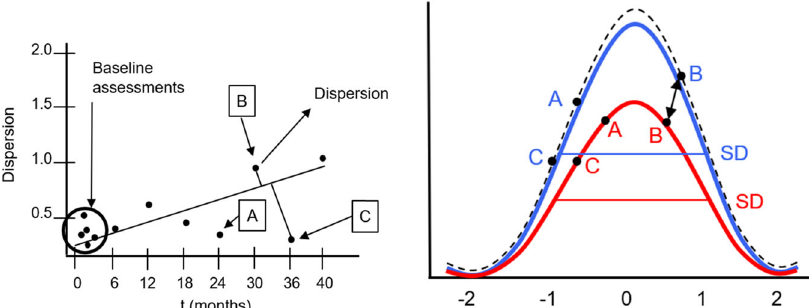
Fig. 5 An illustration of dispersion. Left: Individual patient data over time. Right: patient performance dispersion (dots) at different time points (A, B, and C) represented in population mean (line) picked up using Altoida (blue, top curve) and conventional NP (red, bottom curve). SD is related to the dispersion of a given subject over time (LTRS). Black (dashed line): true dispersion.